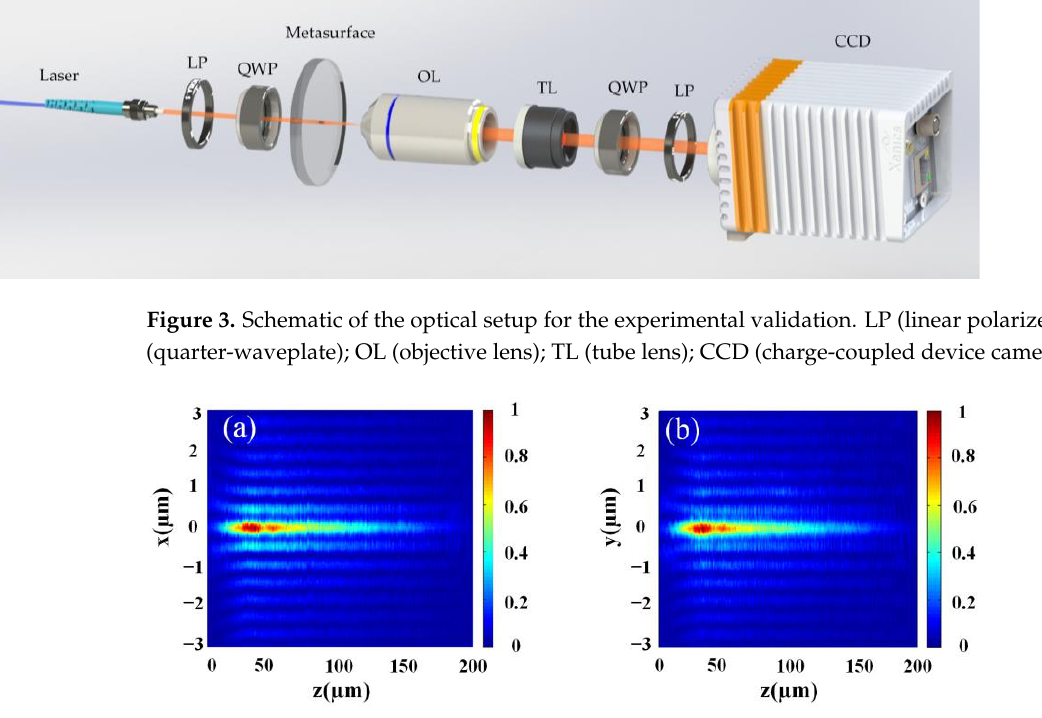
Figure 4. Light field profiles of the BBs with NA 0.7 at the wavelength λ d = 587 nm along the longitudinal direction; ( a ) x-z plane ( b ) y-z plane.